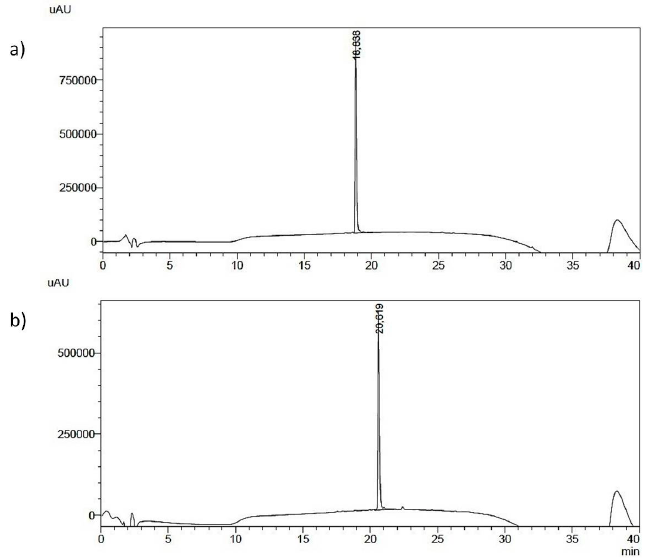
Figure 2. HPLC elution profile of purified peptides ( a , b ).